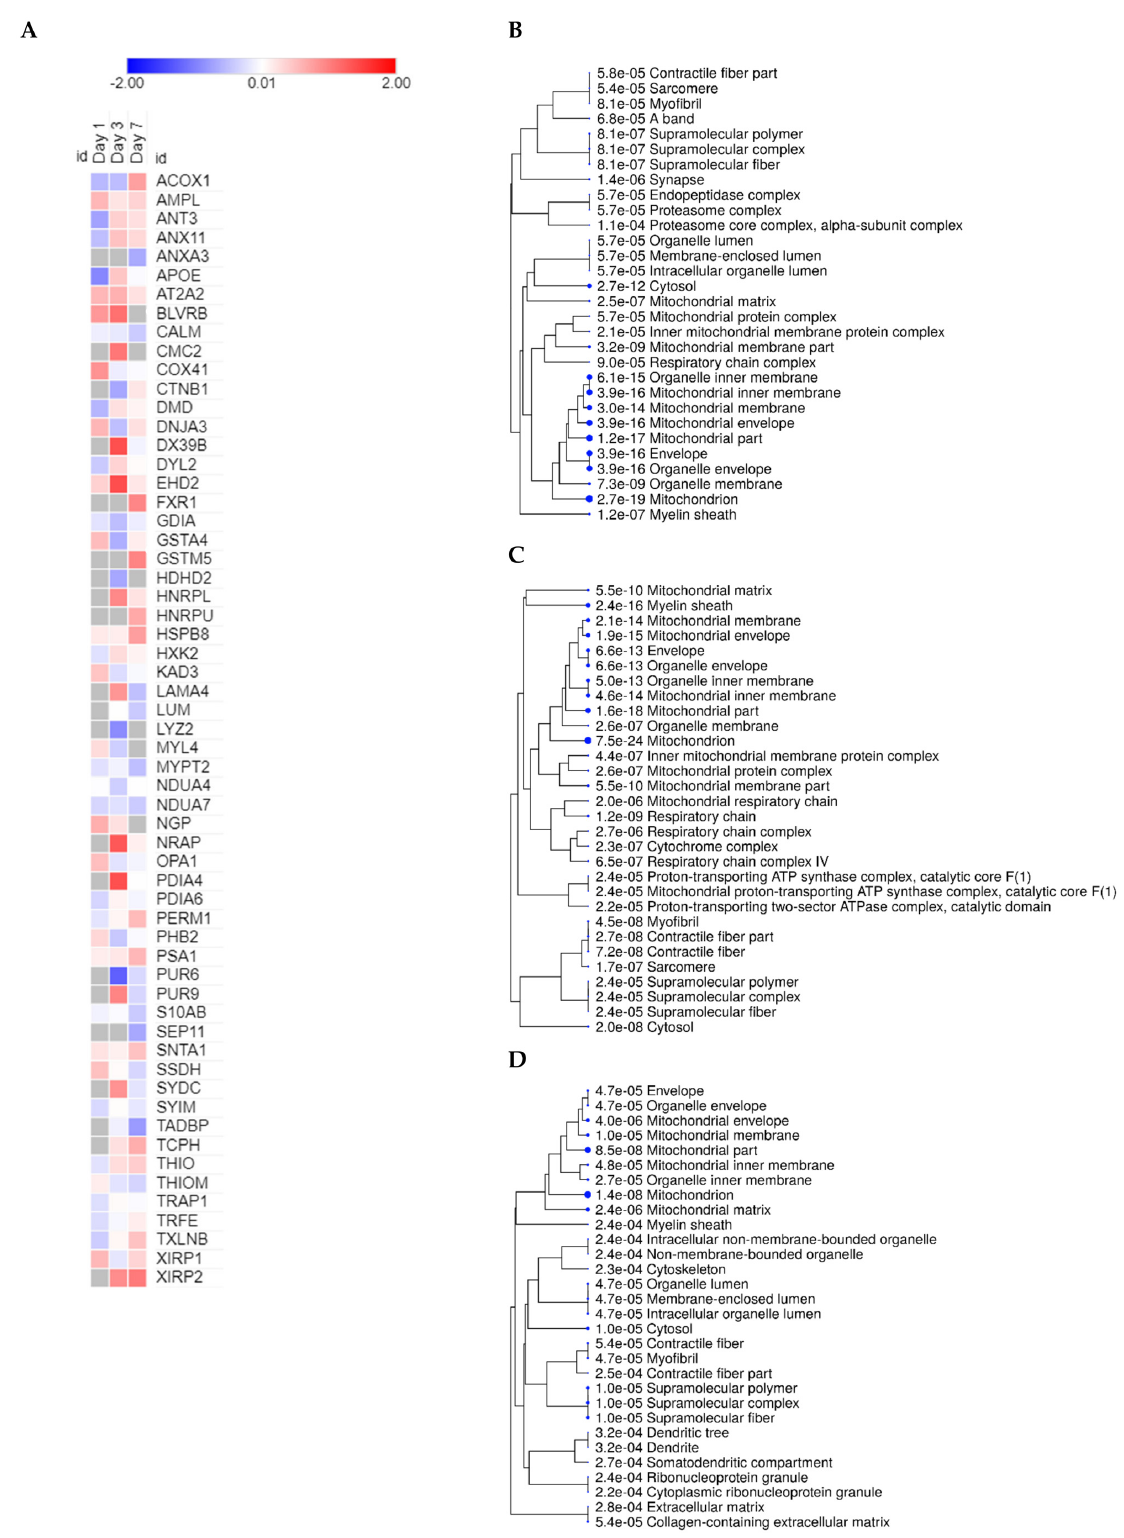
Figure 4. Heatmap of the top 20 significant DEPs and ShinyGO analysis of cellular components from the cross-comparative analysis. A cross-comparative analysis was done at each time point (1, 3 or 7 days after PCAL) between DMB vs. vehicle-treated mice to identify DEPs ( p < 0.05). The log2 fold-change values from the top 20 DEPs at each time point